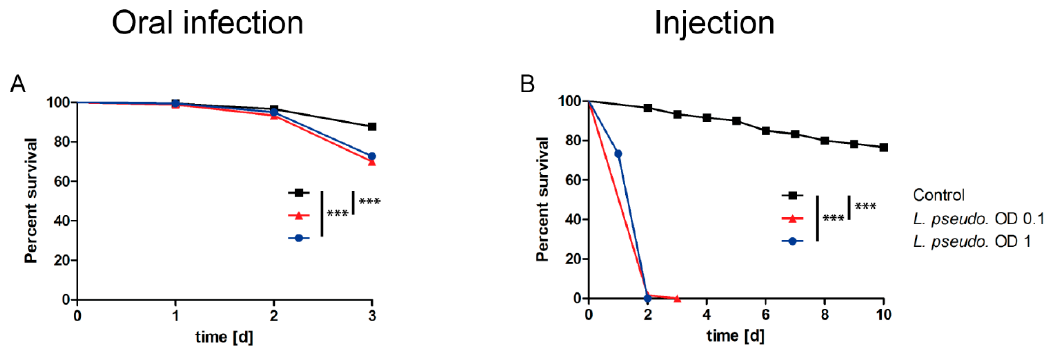
Figure 3. Survival curves for the oral and septic infection of Acyrthosiphon pisum nymphs (5 days old) with Leuconostoc pseudomesenteroides . ( A ) Oral infection with L. pseudomesenteroides suspension (OD 600 = 1 or 0.1) or sterile advanced AP3 medium as a control followed by survival analysis for 3 days. We tested 540 aphids in total (n = 180 per treatment). ( B ) Injection of nymphs with 25 nL of L. pseudomesenteroides suspension (OD 600 = 1 or 0.1) or PBS as a control followed by survival analysis for 10 days. For the injection, each treatment represents a total of 60 aphids (n = 180). Survival data were tested for significance using the logrank test. Each graph is a composition of three biological replicates. Statistical significance is indicated as follows: p ≤ 0.0009 ***; p ≤ 0.009 **; p ≤ 0.09 *; ns, not significant.